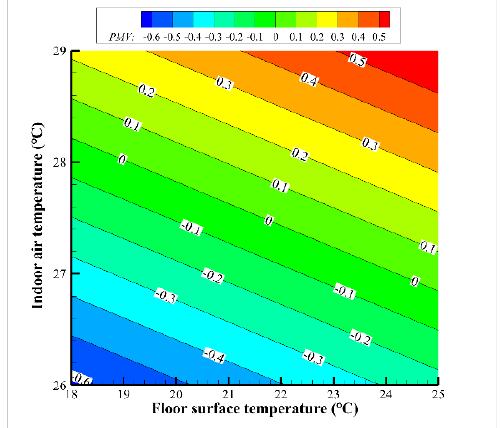
Figure 4. Temperature regulation diagram with PMV as the